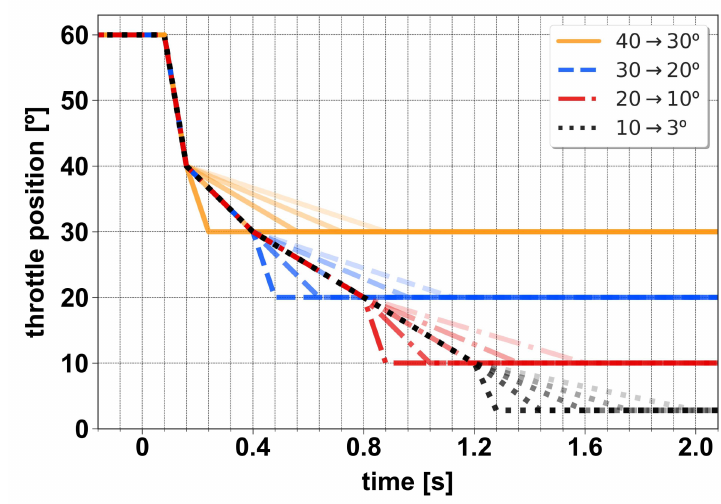
Figure 2. Optimization of throttle